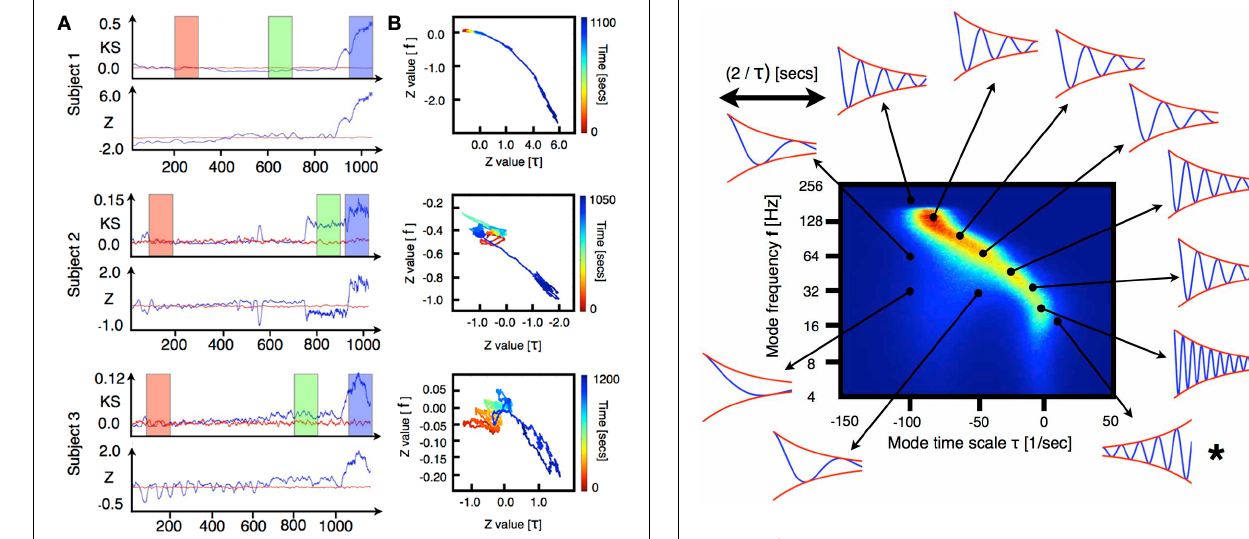
FIGURE 2 | Qualitative behavior of eigenmodes. The histogram corresponds to the eigenmodes of VAR-1 processes fitted to ECoG signals. The count in each bin is color-coded and the number of samples is N > 10 6 . The frequency axis is in logarithmic scale (base-2). The arrows indicate points in the stability plane for which the qualitative dynamics of the corresponding mode is illustrated. The dynamics of each mode can be expressed as an oscillation of frequency f whose amplitude (red curves) is modulated by an exponential decay/growth (blue curve). Each solution is shown for 2 /τ s. Note that for the points in the plane with non-zero count, a number of oscillations occur before the mode is damped out. For the case labeled with (cid:8) , the mode grows exponentially (i.e., it is